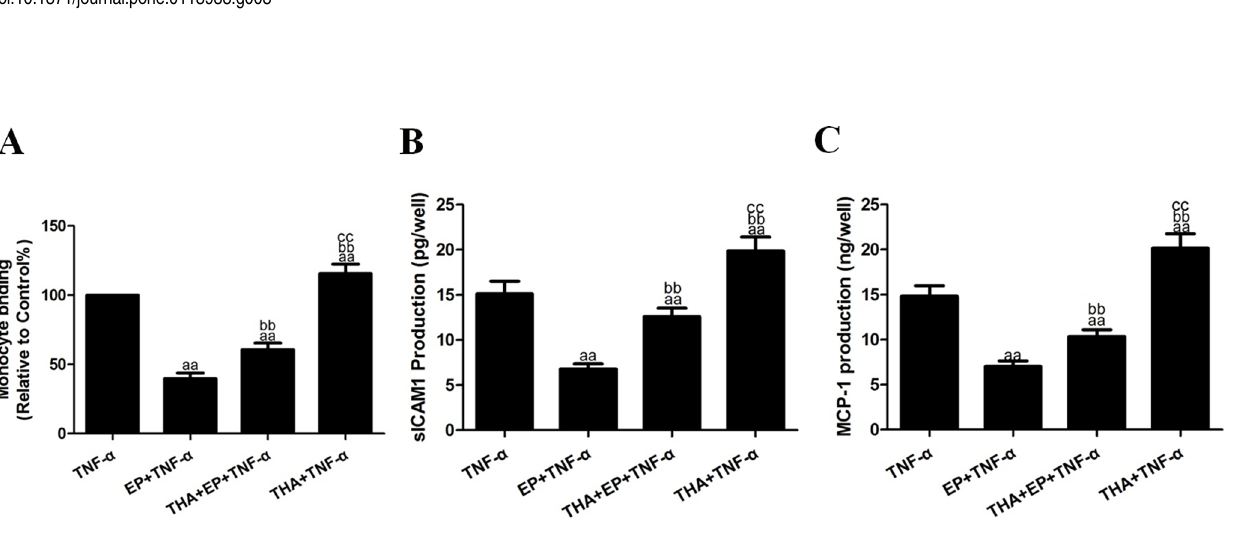
PLOS ONE | DOI:10.1371/journal.pone.0113983 December 3,